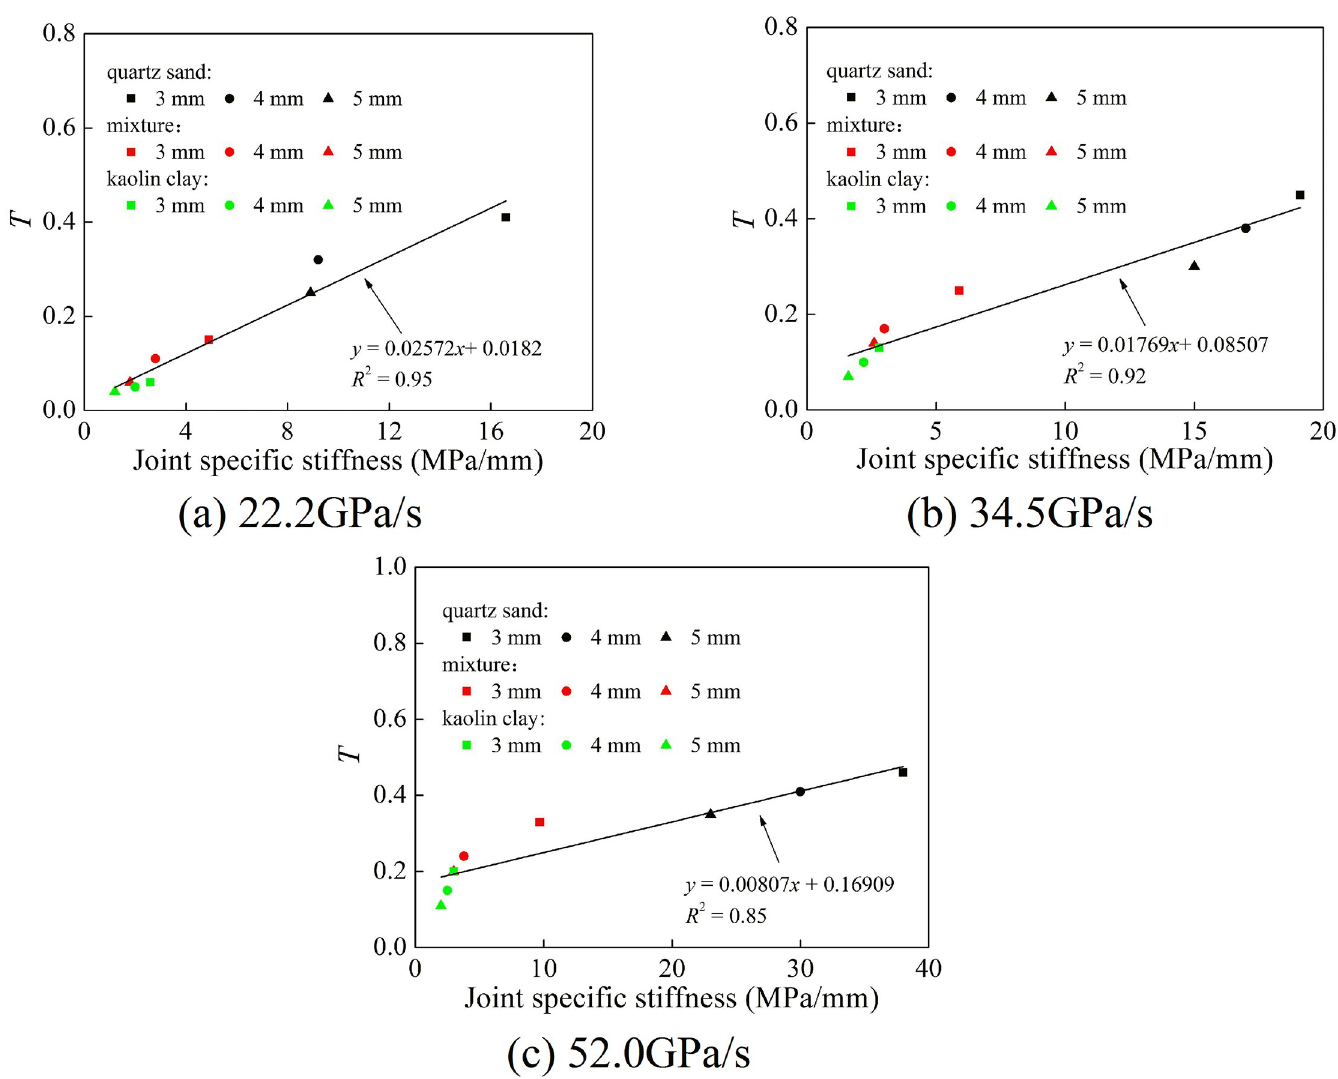
Fig 15. Variation of the transmission coefficient with the joint specific stiffness. (a) 22.2 GPa/s (b) 34.5 GPa/s (c) 52.0 GPa/s.